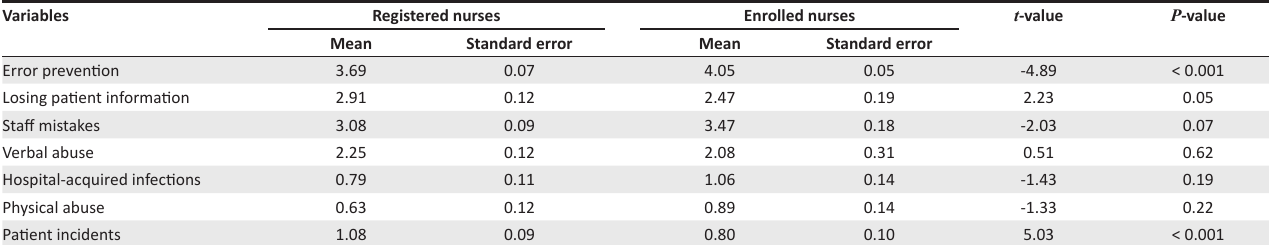
TABLE 7: Results of Hierarchical Linear Models for educational background and the safety and quality of patient care.